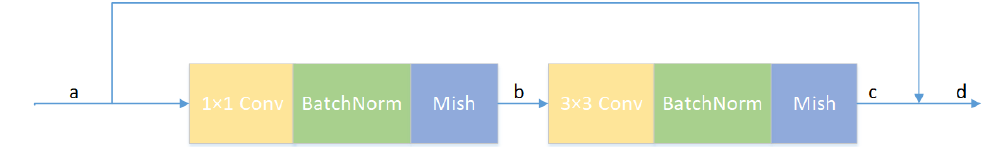
Figure 4. The architecture of the lightweight residual module.